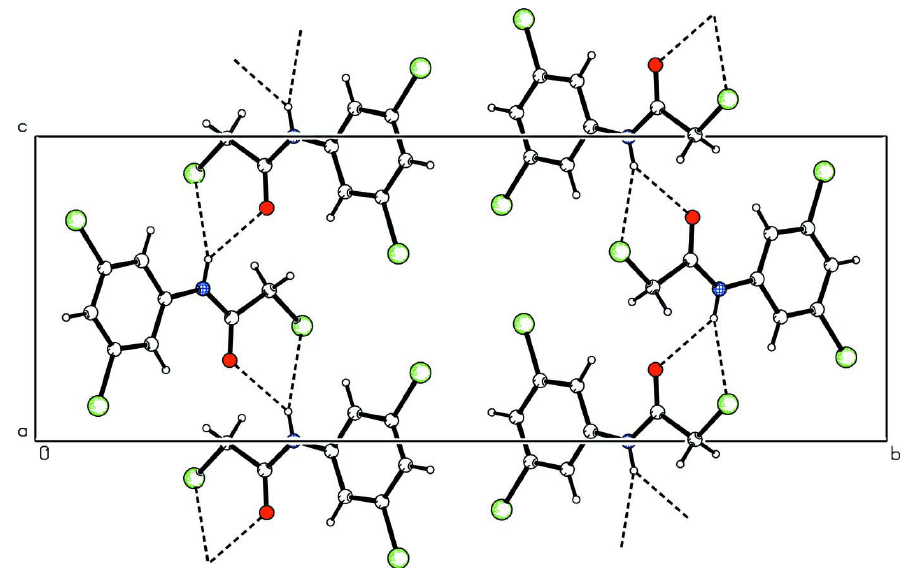
Figure 2 Molecular packing of the title compound with hydrogen bonding shown as dashed